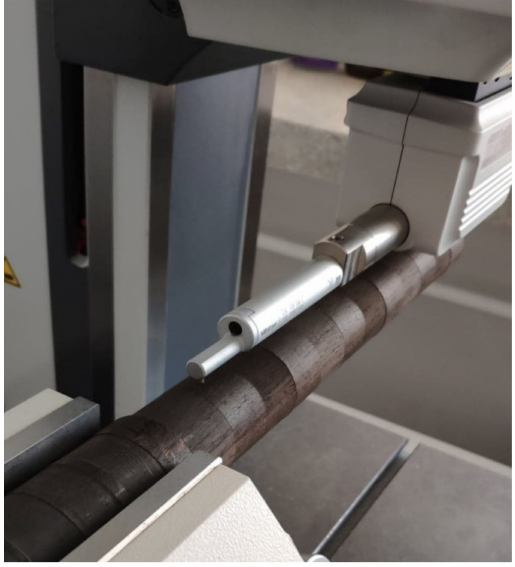
Figure 5. Placement of measurement head’s needle on examined Diospyros crassiflora